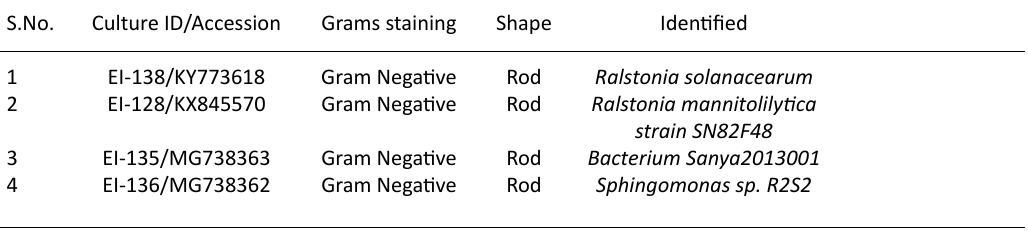
Table 3. Identification and Molecular Characterization of microbial isolates